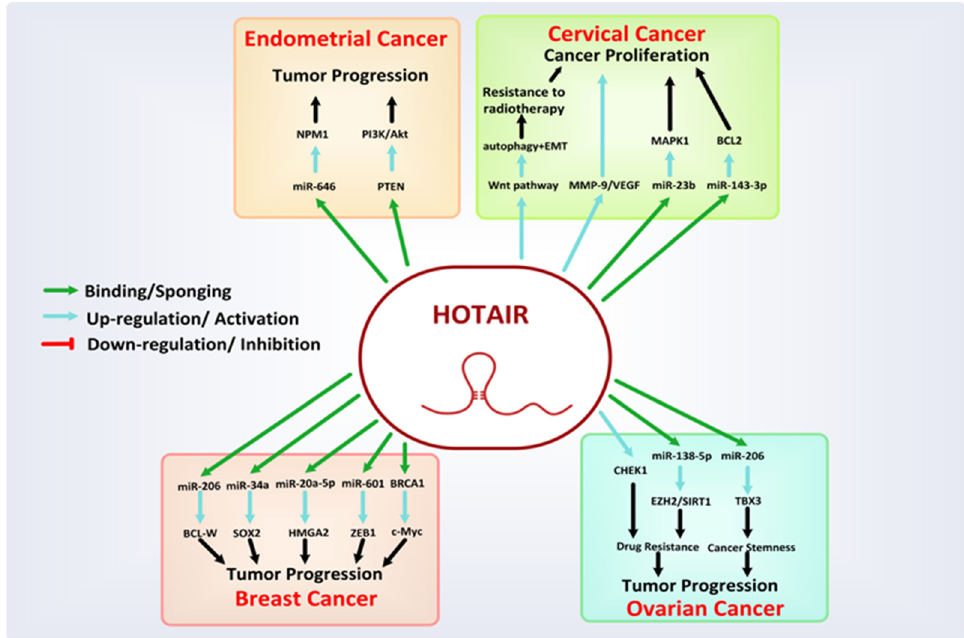
Figure 4. Mechanism associated with the oncogenic role of HOTAIR in female-oriented cancers.